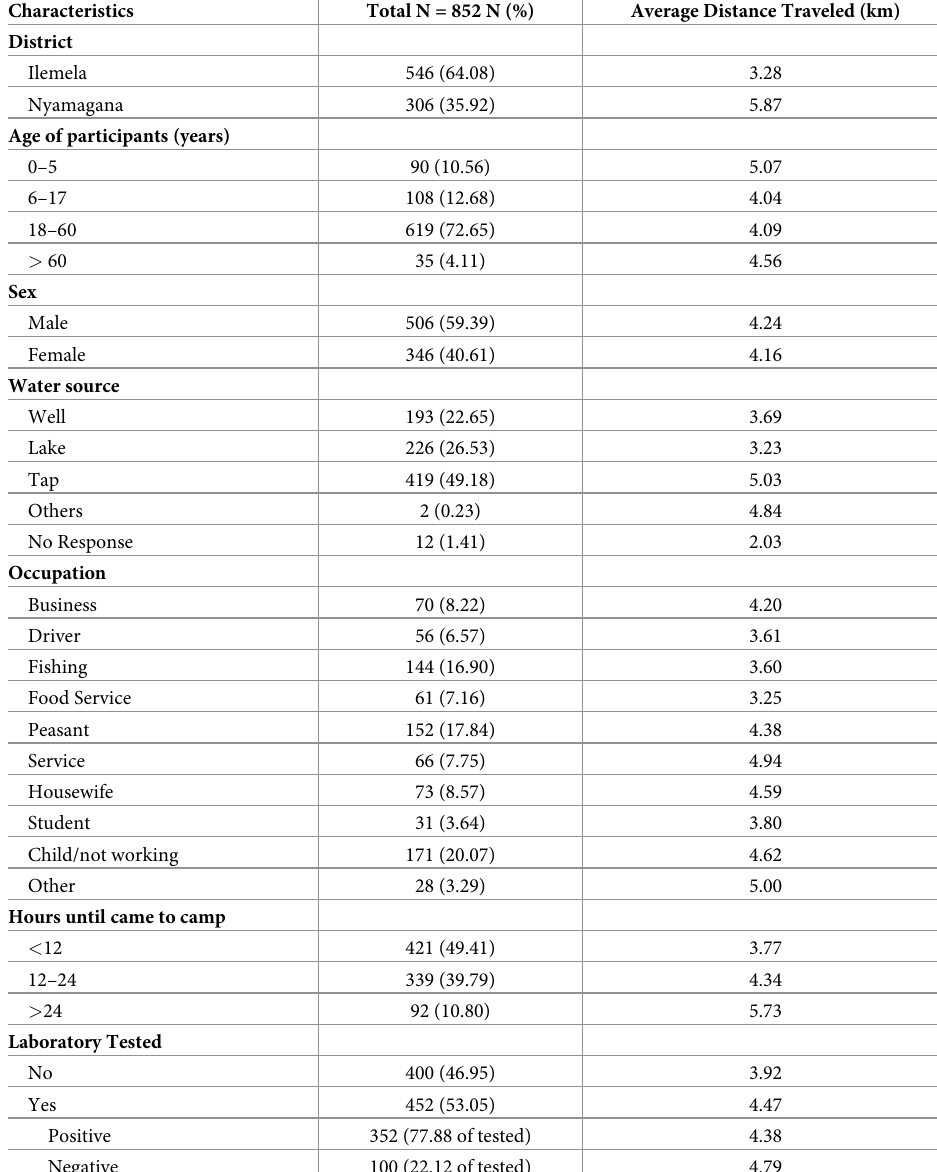
Table 1. Characteristics of suspected cholera